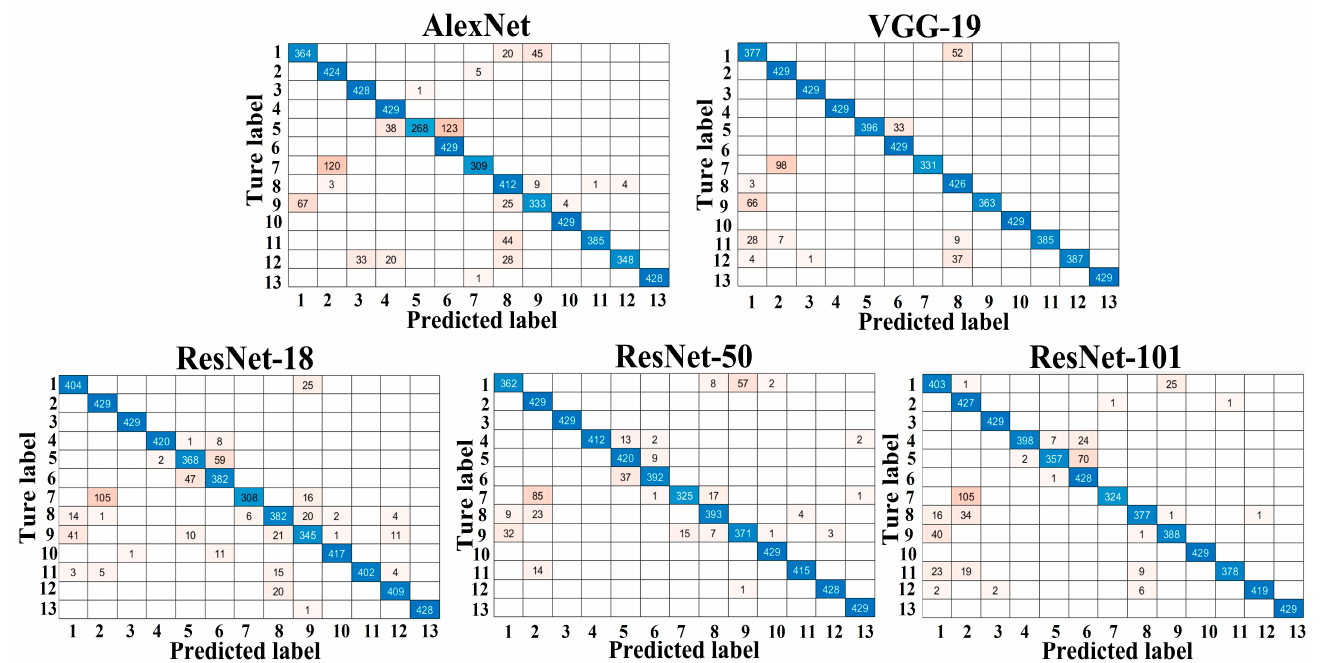
Figure 3. Confusion matrix of the different trained models for dataset B. Table 2. Comparison of the different trained models.